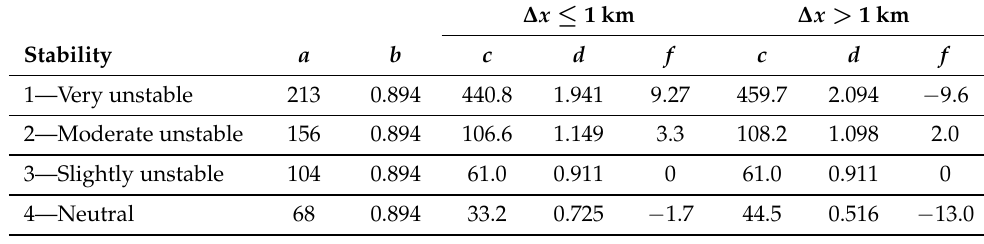
Table 3. Stability coefficients based on the Gaussian dispersion model.